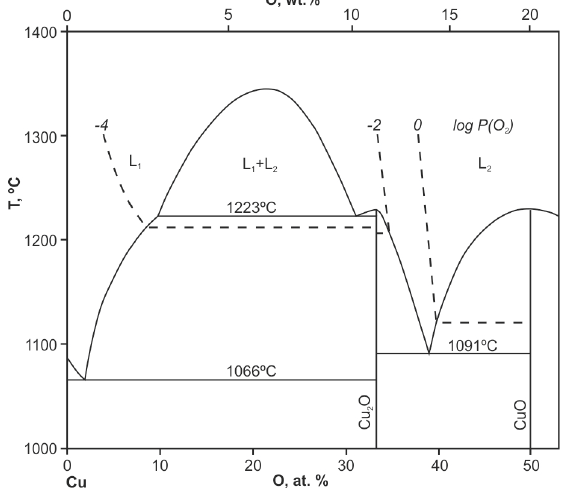
Figure 19. Phase diagram for the Cu-O system modified after [83]. Isobaric curves for log P(O 2 ) are shown by the dashed line.